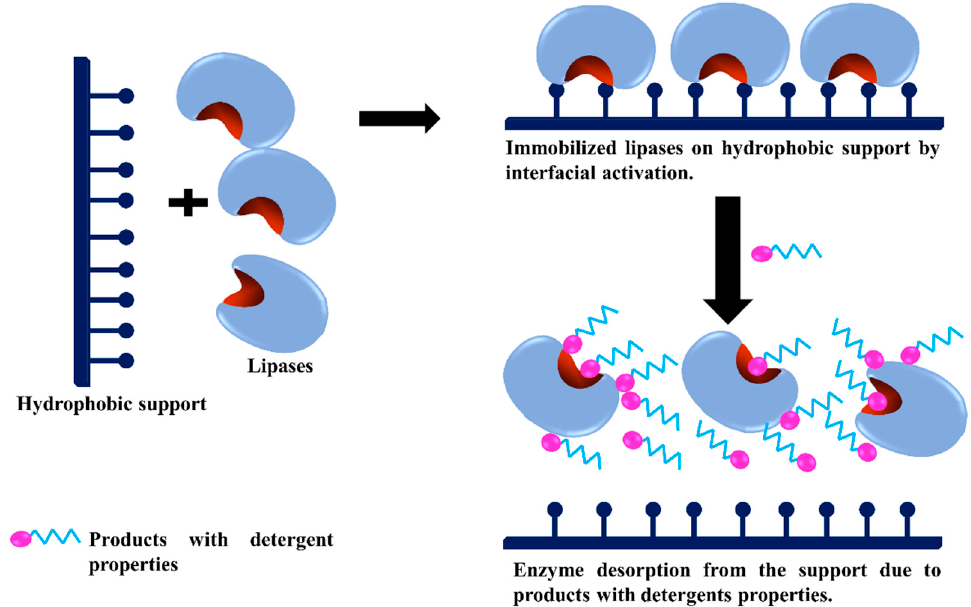
Figure 20. Release of lipases from hydrophobic supports in the presence of detergent like substrates or product (mono or diglycerides, free fatty acids, etc).